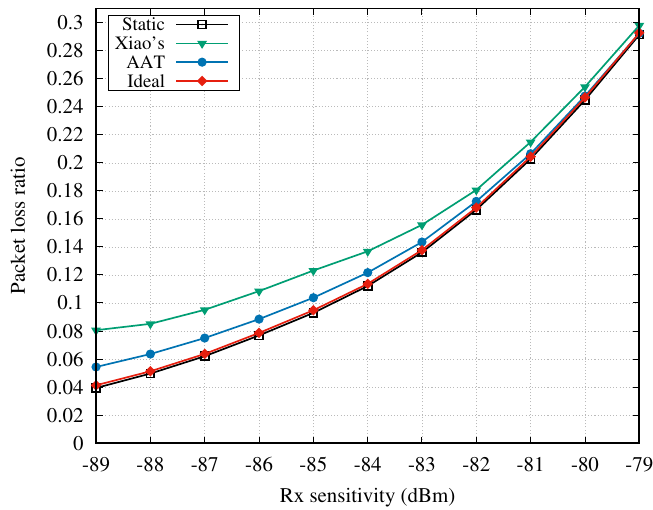
Figure 6. Packet loss ratio vs. Rx